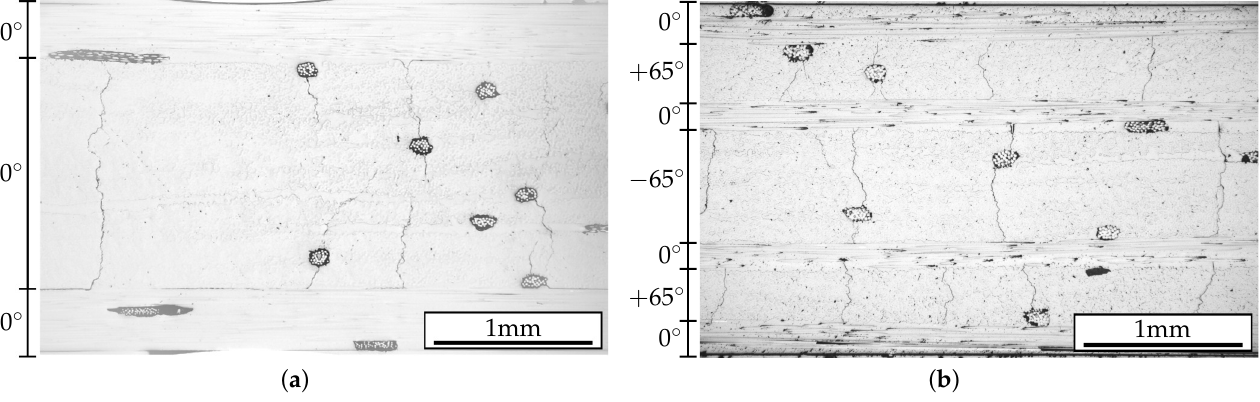
Figure 6. Edge micrographs of ( a ) [ 0 2 /90 4 ] s and ( b ) [ 0/ + 65 2 /0/ − 65 2 ] s laminate after fatigue testing for n = 5 × 10 5 loading cycles. The dark cylindrical and elliptical areas represent bonding yarns. In ( a ), delaminations occurred during testing at the layer interfaces, emanating from the tips of the transverse matrix